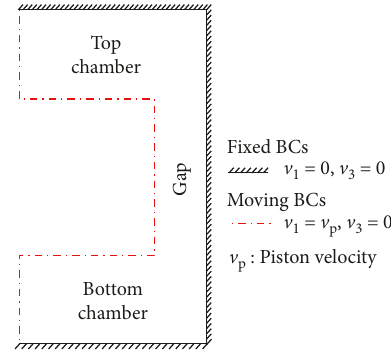
Figure 3: Boundary conditions for flow